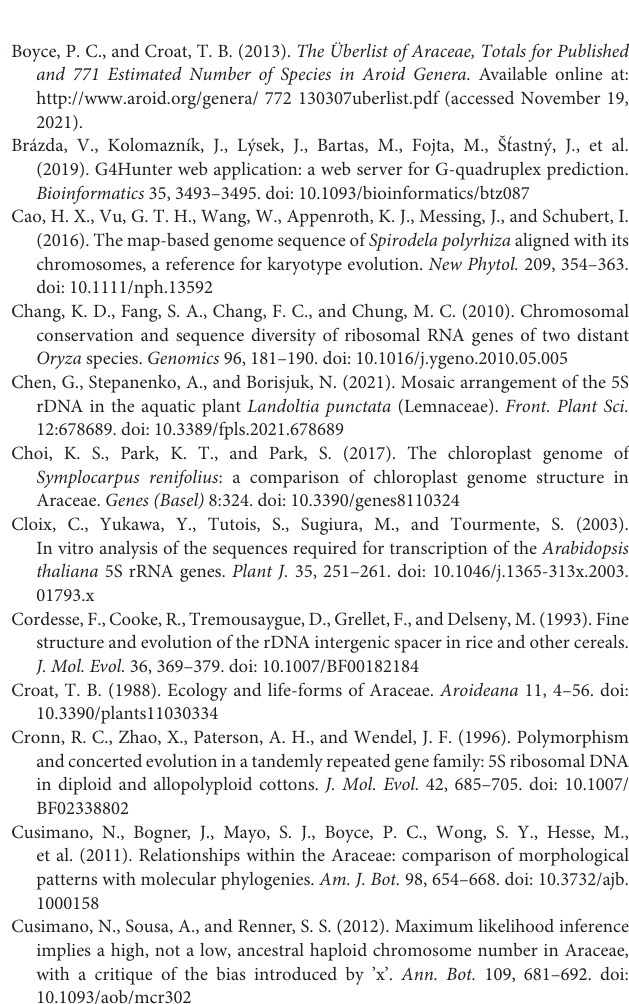
highlighted in blue. The accession numbers of the representative sequences deposited in GenBank are as follows: Ps19: OL409055; Ps20: OL409052; Ps22: OL409056; Ps28: OL409060; Ps29: OL409057; Ps30: OL409058; Ps31: OL409059; Ps32: OL409061; Ps33: OL409062; Ps34: OL409063; Ps35: OL409064; Ps36: OL409065. Supplementary Figure 9 | Patterns of G-quadruplex structures predicted for Type II 5S rDNA NTS sequences of P. stratiotes . Patterns of G-quadruplex structures predicted for Type II-a (A) , represented by clone Ps19 (accession no. OL409055) and Type II-b (B) , represented by clone Ps20 (accession no. OL409052). The heights of the peaks indicate the relative strength of each G-quadruplex structure; numbers indicate nucleotide positions relative to the transcription start of the 5S rDNA gene; the filled box corresponds to the position of the sequence TCCTCCCCTCCCTCGACAT in Figure 5C . Supplementary Figure 10 | Sequence alignment of three PCR fragments containing the canonical 5S rDNA gene sequence ( Ps9 ) and pseudogenes ( Ps20 and Ps21) . The 5S rDNA gene variants are marked by green rectangles. The identifications of the sequences are as follows: Ps9: OL450405; Ps20: OL409052; Ps21: OL409053. Supplementary Figure 11 | Sequence alignment of the six PCR fragments amplified with primers specific for Type I-a and Type I-c NTSs. Type I-a NTS sequences are marked by red rectangles, 5S rDNA by green rectangles, and Type I-c NTSs by blue rectangles. The identifications of the representative sequences are as follows: Ps62—OL409066;